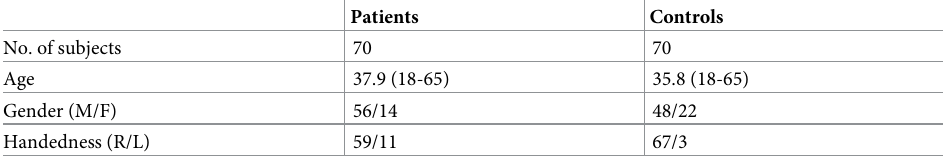
Table 1. Summary of participant demographics in the COBRE schizophrenia